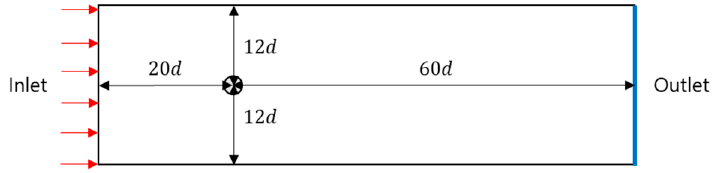
Figure 1. Schematic views of the computational domain.